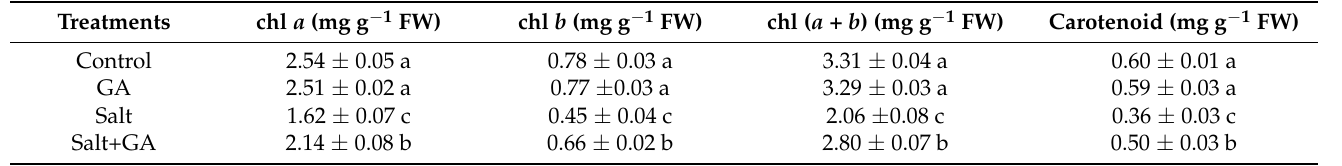
Table 2. Photosynthetic pigments of salt-treated rice ( O. sativa L. cv. BRRI dhan52) seedlings as influenced by GA